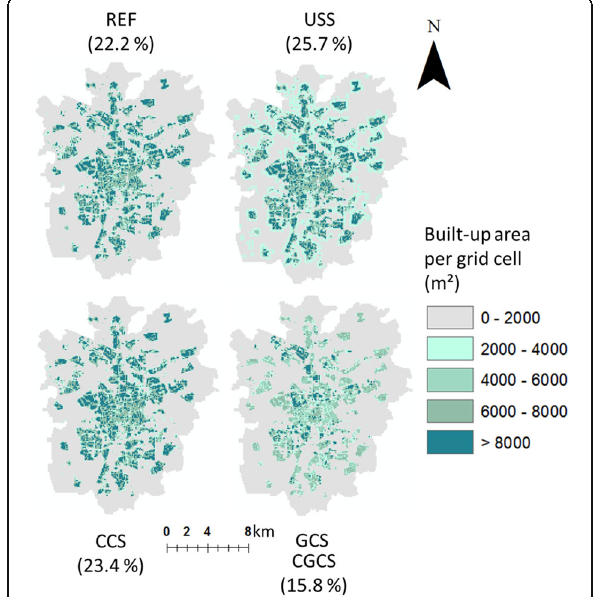
Fig. 2 Built-up area per grid cell (100 × 100 m grid cell) in Braunschweig for the reference case (REF) and for step 10 of the respective scenarios (USS: Urban Sprawl Scenario, CCS: Compact City Scenario, GCS: Green City Scenario, CGCS: Compact Green City Scenario). Step 10 indicates the maximum amount of built-up area, i.e. summed over step 1 – 10. Additionally, total built-up area is quantified in percent of total urban area (in